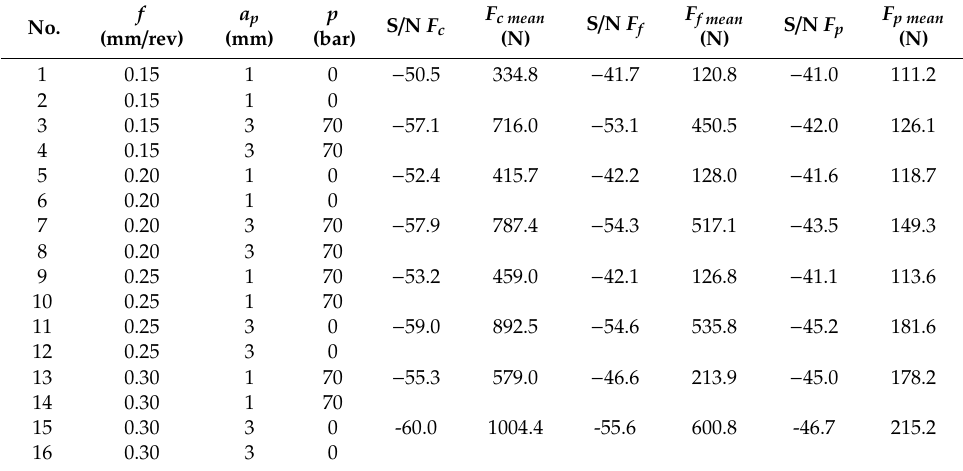
Table 4. Test results for cutting forces measurements F c , F f , F p .